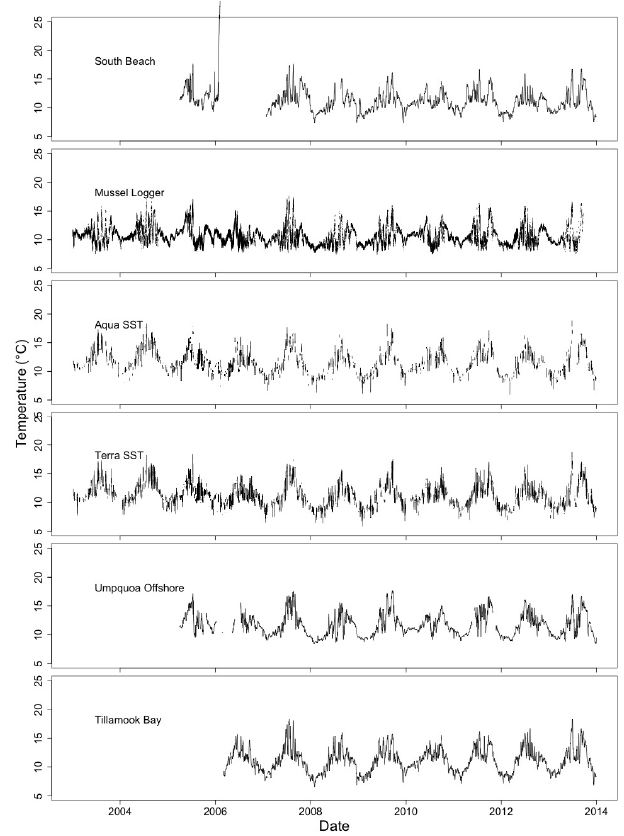
Figure 2. Time series graphs of daily logger temperatures, satellite-derived sea surface temperatures (SST), and local water temperatures from 2003 − 2013. The entire available data record from 2003 − 2013 for each location is shown above. The South Beach station, Umpquoa Offshore buoy, and Tillamook Bay station have many missing daily temperatures as shown by breaks in the time series.